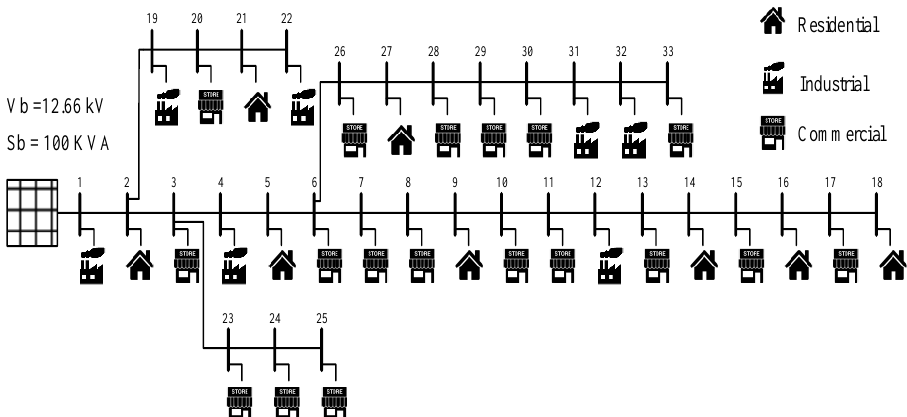
Figure 5. Single-line diagram of the studied 33-bus system.